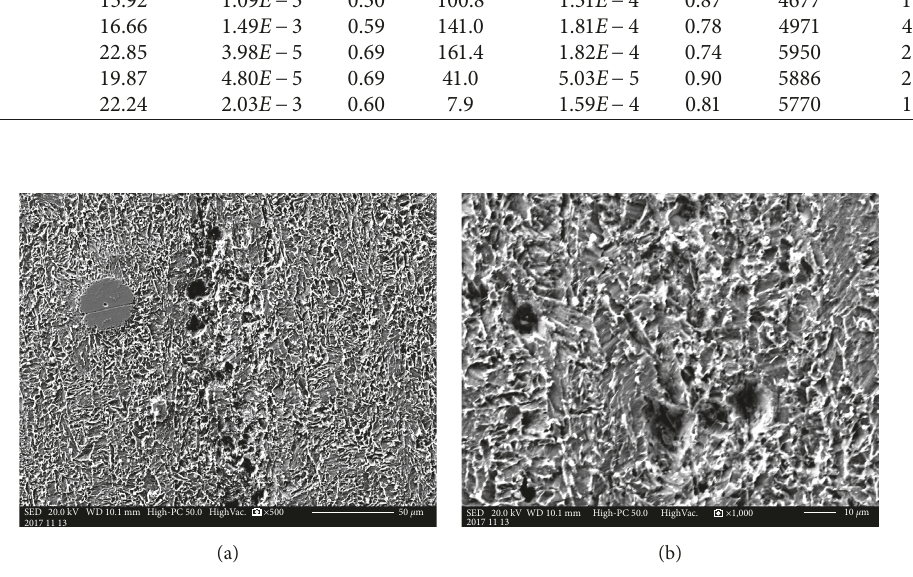
Figure 9: Morphological aspect of API X70 steel after 100 hours of immersion in 3.5% NaCl